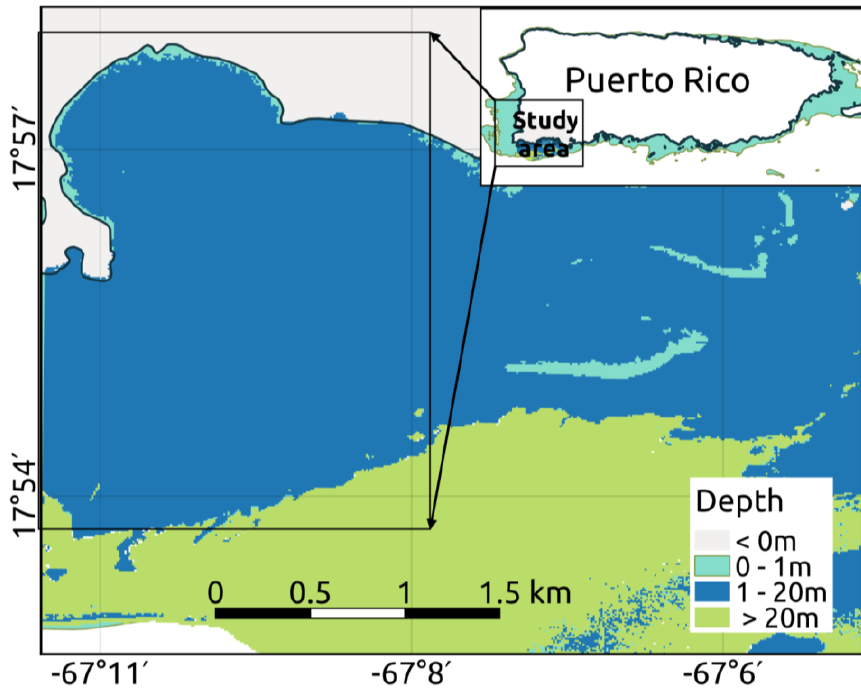
Figure 2. Case study 1: Study area, Puerto Rico, Northeastern Caribbean Sea.